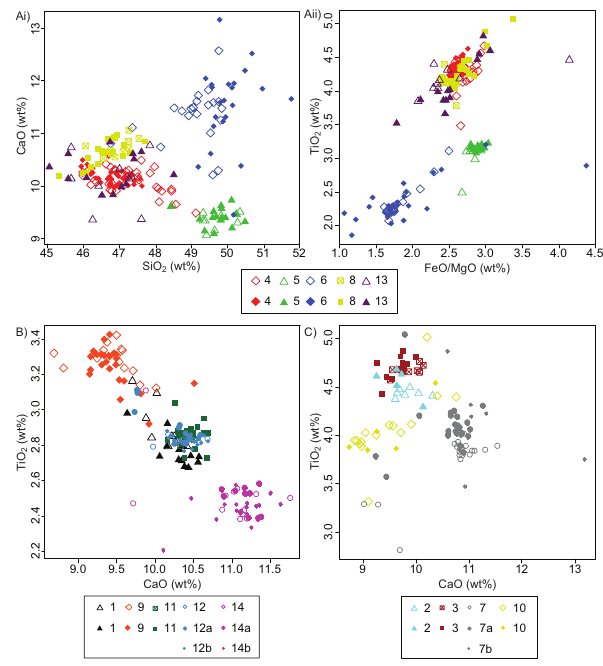
Fig. 2. Biplots showing the tephra horizons matched between the NEEM and NGRIP cores. The tephras are numbered according to Table 1. Correlative tephra horizons are represented by the same shape and colour symbols, with NEEM layers represented by open symbols and NGRIP layers by filled symbols. (A) biplots for the tephra layers included in the timescale transfer. (Ai) plot of SiO 2 vs. CaO and (Aii) plot of FeO/MgO vs. TiO 2 . (B) biplot of CaO vs. TiO 2 for the remaining tholeiitic basalt layers and (C) biplot of CaO vs. TiO 2 for the remaining transitional alkali basalt